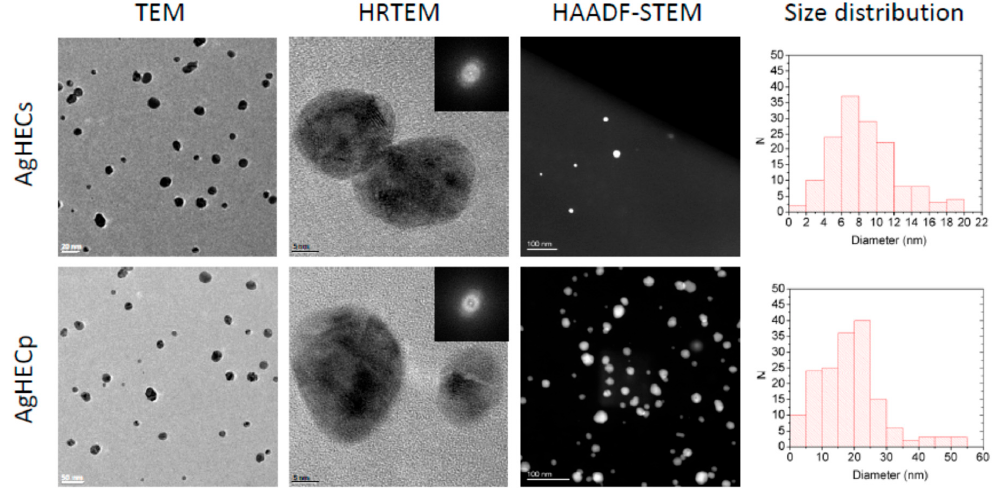
Figure 1. Transmission electron microscopy images of AgHEC NPs. TEM pictures were used for the morphological characterization of the NPs, HRTEM were used to determine the diffraction patterns of the novel particles while the HAADF-STEM to determine the size distribution of the particles.